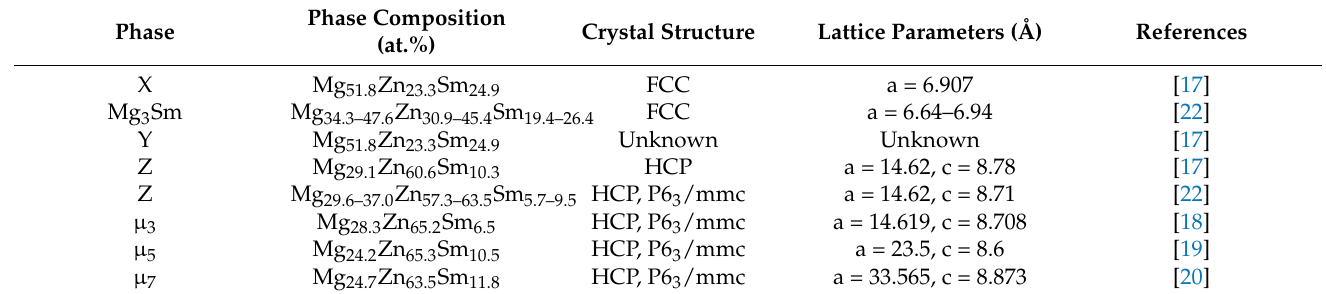
Table 1. Summary of ternary compounds from different